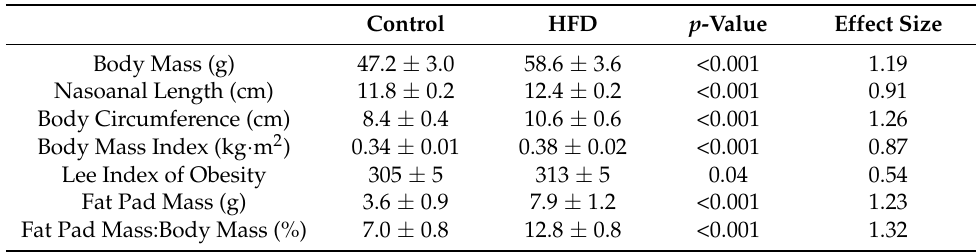
Table 1. The effects of 9 weeks of a high-fat diet (HFD) on animal anthropometrics for 79-week-old mice.